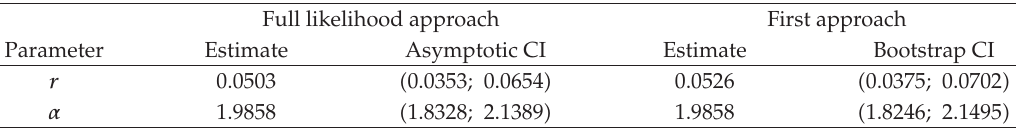
Table 3: Point estimates and approximate 95% confidence intervals of r and α using the full likelihood and using the first approach. Note: the true parameter values are r (cid:5) 0 . 05, α (cid:5)